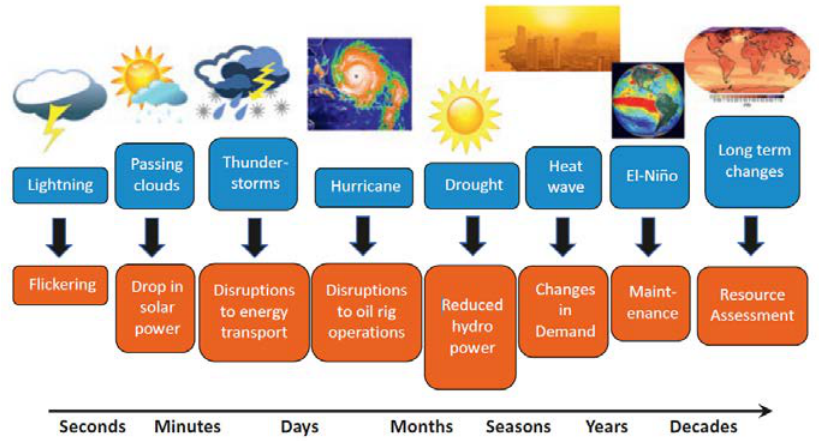
Figure 1. Meteorological phenomena impact on the energy sector (source: [10]). El Nino is the name for the ENSO phase (EL Nino–Southern Oscillation,